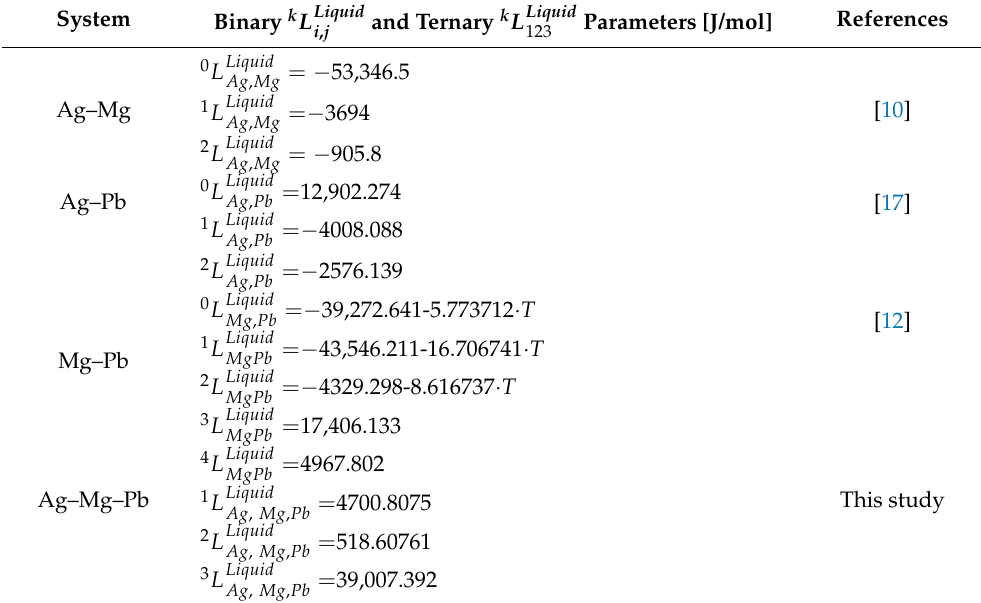
in Equation (4) for 123